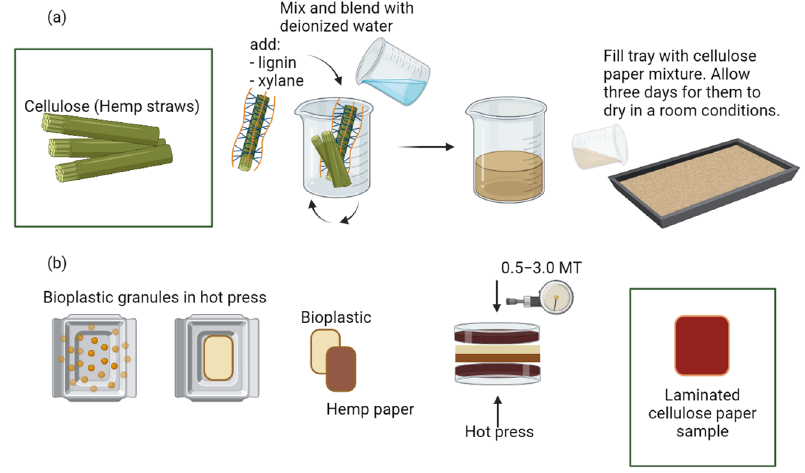
Figure 1. Scheme of ( a ) hemp paper preparation, ( b ) paper lamination